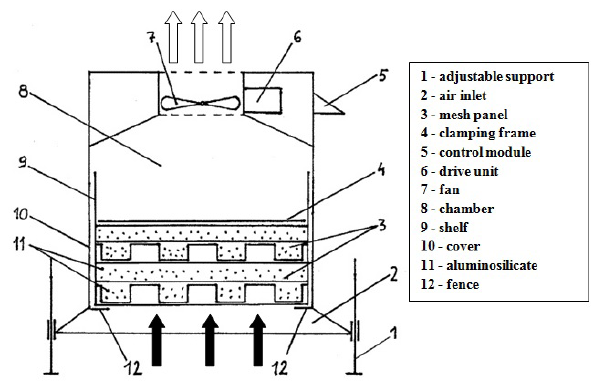
Figure 1: Schematic of the ODOR1 device (Kijas et al., 30 September 2013, Polish Patent PL 214915